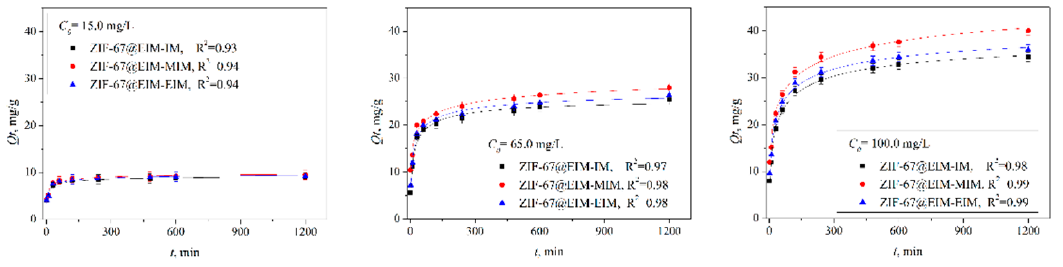
Figure 4. The adsorption of AAI onto three dual IL-immobilized ZIF-67 sorbents at 25 °C with the pseudo-first-order